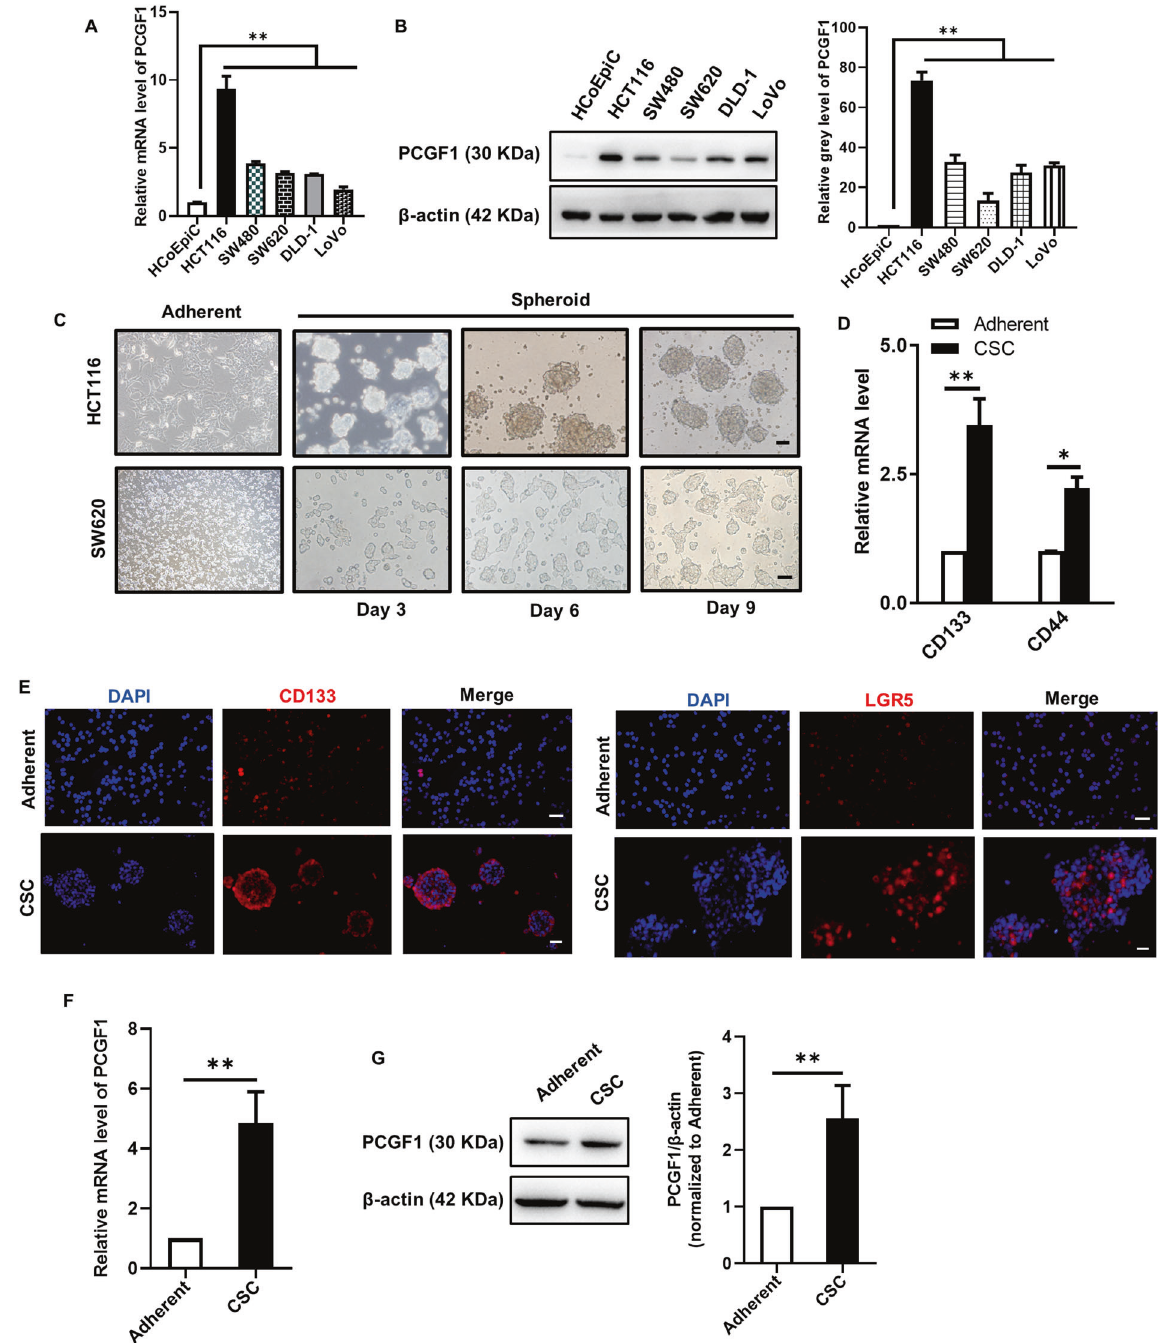
Fig. 2 PCGF1 is highly expressed in colorectal cancer stem cells. A , B RT-qPCR and western blot analysis of the PCGF1 mRNA and protein levels in HCoEpiCs and a panel of CRC samples, and the relative intensity values (PCGF1/ β -actin) were measured with ImageJ software. C HCT116 and SW620 cells were cultured in a serum-free environment for 9 days. Sphere morphology was photographed using light microscopy. Scale bar, 50 µm. D RT-qPCR analysis of the expression of CD133 and CD44 in colorectal cancer stem-like cells and adherent cells. E The expression levels of the stem cell markers CD133 and LGR5 were detected by immuno fl uorescence staining. Scale bar, 50 µm. F , G RT- qPCR and western blot analysis of PCGF1 mRNA and protein levels in adherent and CSCs, and the relative intensity values (PCGF1/ β -actin) were measured with ImageJ software. **P < 0.01, *P < 0.05, one-way ANOVA and t -test. Data are shown as the mean ± SEM of at least three replicates. β -actin was used as a loading PCGF1 promotes colorectal cancer stem cell enrichment immuno fl uorescence staining (Fig. 2D, E). PCGF1 mRNA and A PCGF1 loss-of-function subclone was generated in HCT116 cells, protein were more highly expressed in CSCs than in bulk CRCs which have high endogenous PCGF1 expression, using a pLKO- (Fig. 2F, G). All the results demonstrate that PCGF1 may be PCGF1 shRNA lentivirus, and a PCGF1 gain-of-function subclone associated with the progression and malignancy of colorectal was generated in SW620 cells, which have low endogenous PCGF1 cancer.